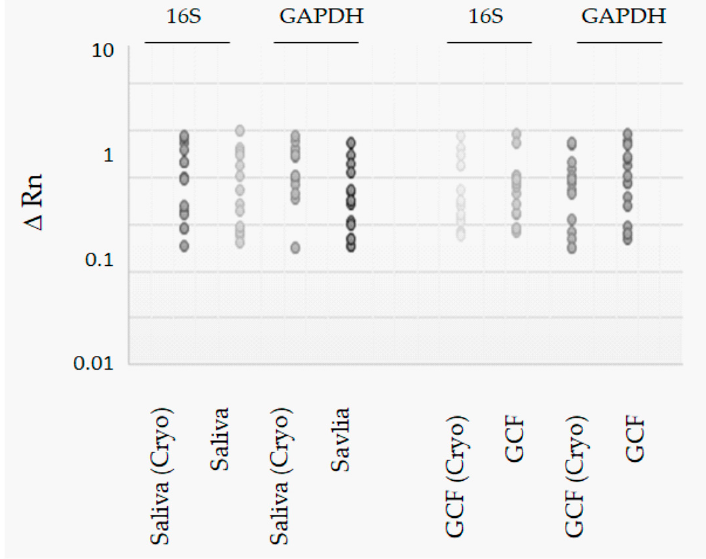
Figure 4. A real-time qPCR screening of cryopreserved and original (fresh) saliva, as well as GCF samples. Screening using universal 16S rRNA bacterial primers and GAPDH human glycolytic pathway primers revealed positive results above the limit of detection ( Δ Rn = 0.01) with no significant differences in the signal intensity for 16S or GAPDH between the cryopreserved and original samples ( p = 0.7401).